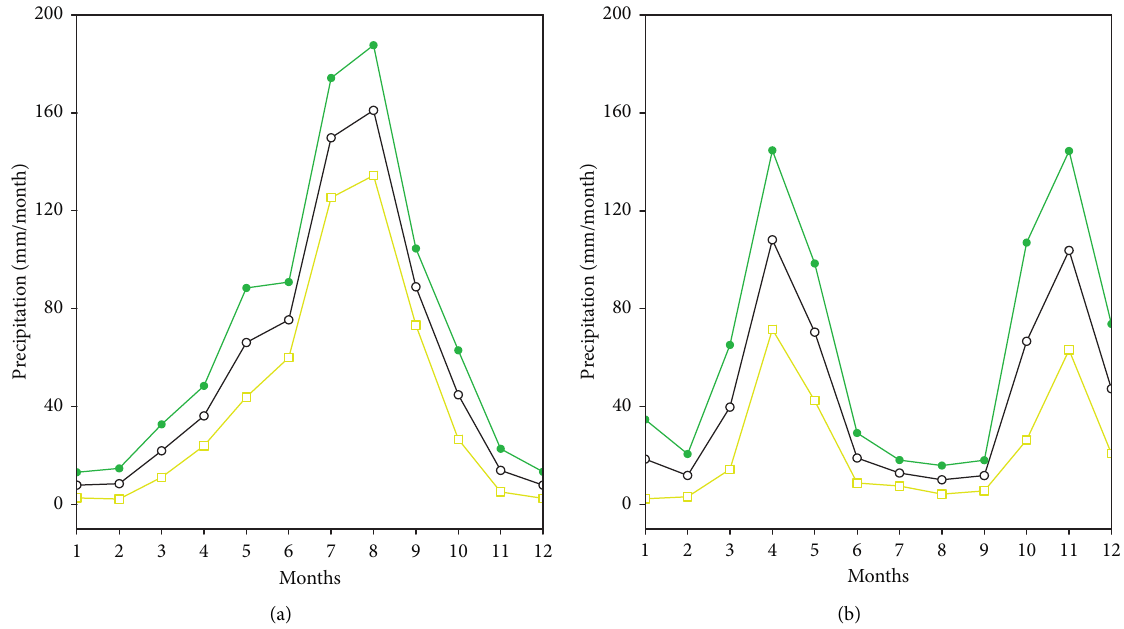
Figure 3: Annual rainfall cycle averaged over (a) the JJAS region and (b) the OND region (red boxes shown in Figure 2(c) and 2(d)). Gray lines are the regions’ average, and green and yellow color lines are the ± 0.1 standard deviation of the interannual variability, respectively.